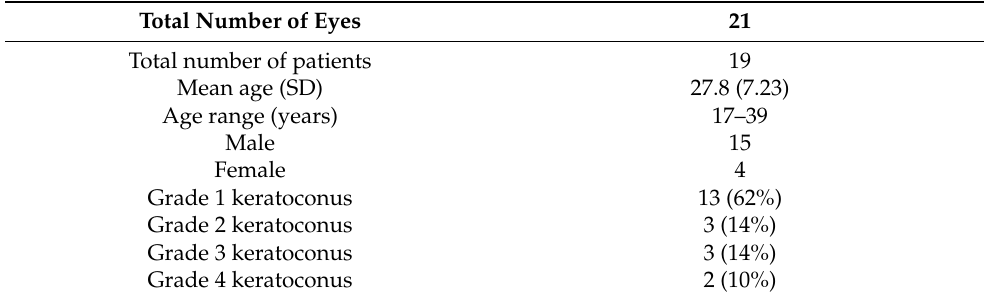
Table 1. Baseline demographics of 21 keratoconic eyes implanted with Ferrara intrastromal corneal ring